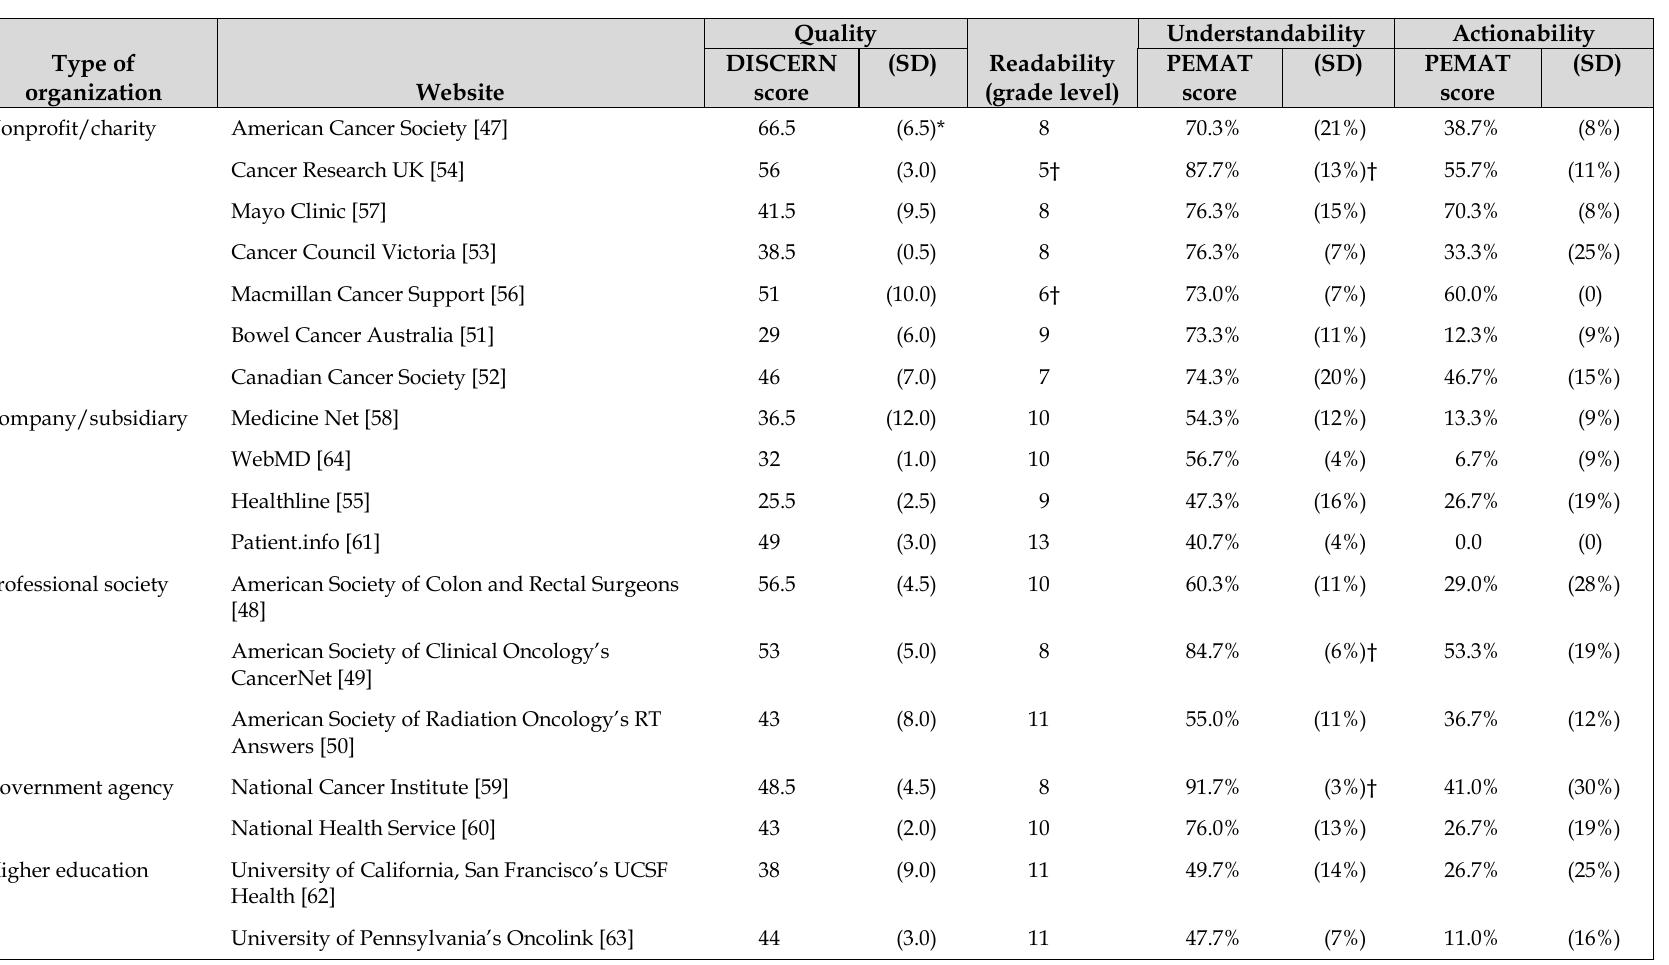
Table 3 Evaluation of website quality and health literacy demand Type